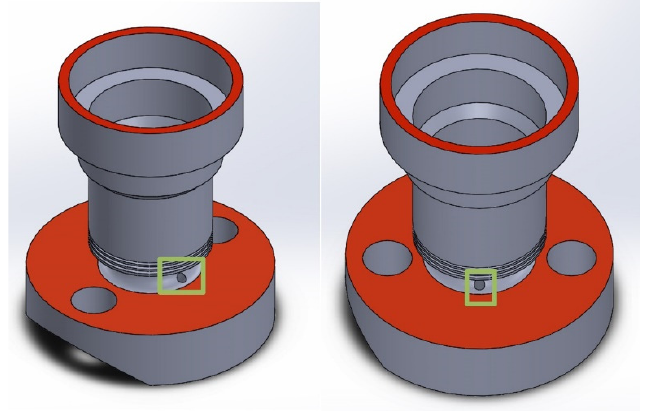
Figure 1. Illustration of the green box detection area for the 3D drawing of the machined metal.